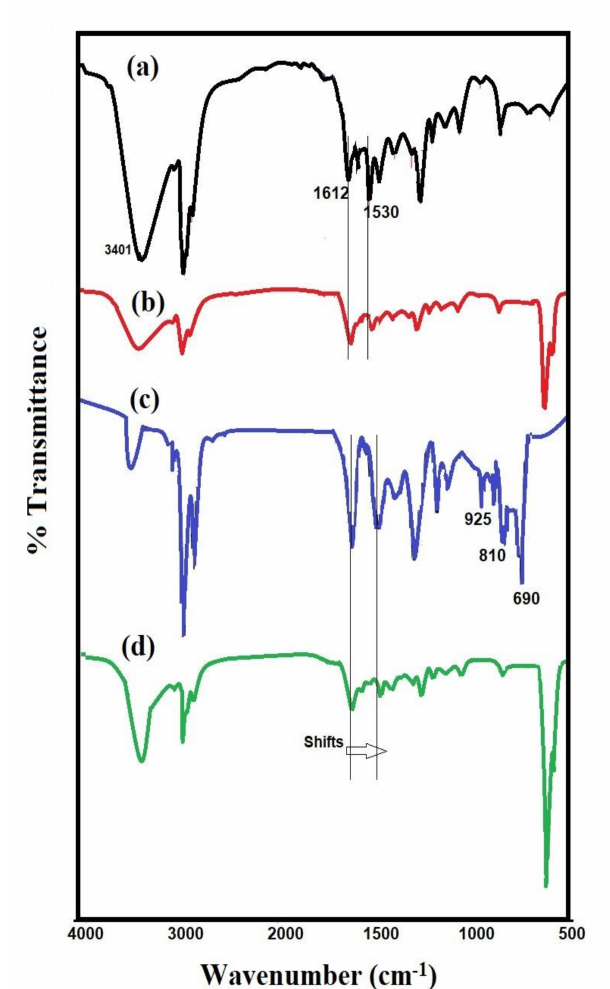
Figure 1. Fourier transform infrared (FTIR) spectra of ( a ) dinonylphenoxy (HPHI), ( b ) HPHI-Fe 3 O 4 , ( c ) dicardanoxy (DCHI), and ( d ) DCHI-Fe 3 O 4 .